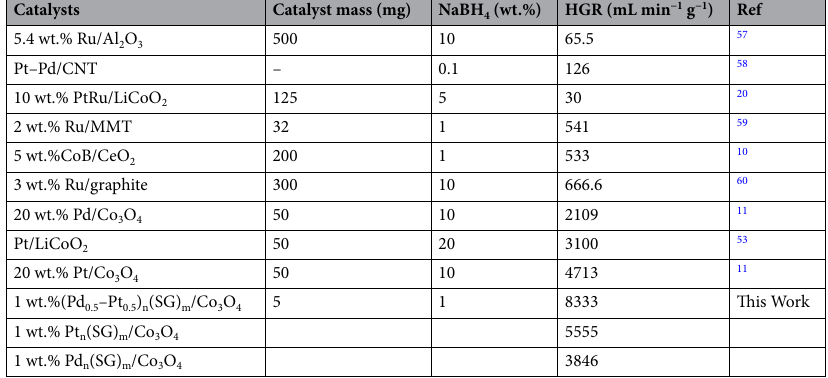
Table 4. Comparison among catalysts used for the hydrolysis of NaBH 4 for hydrogen